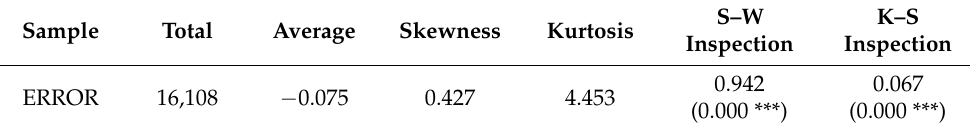
Table 7. Normality test (cm).